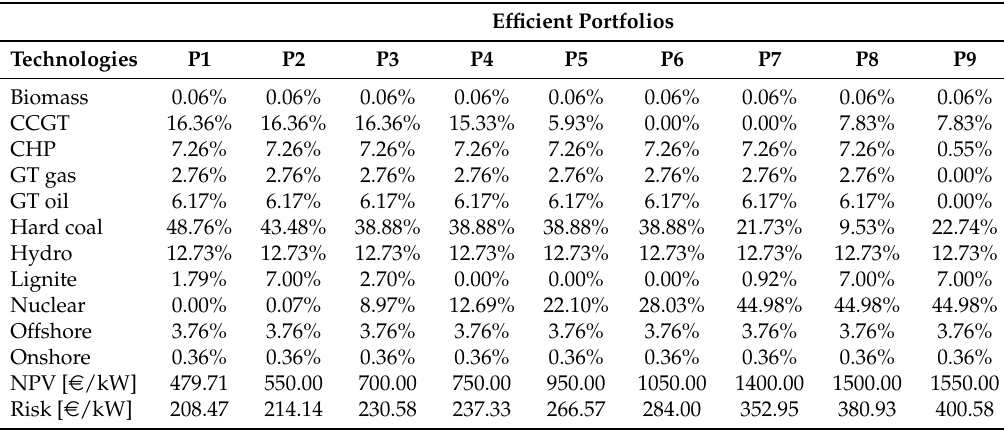
Table A2. Efficient portfolios according to FSMAD Model 1 for existing technologies combined with new investments.